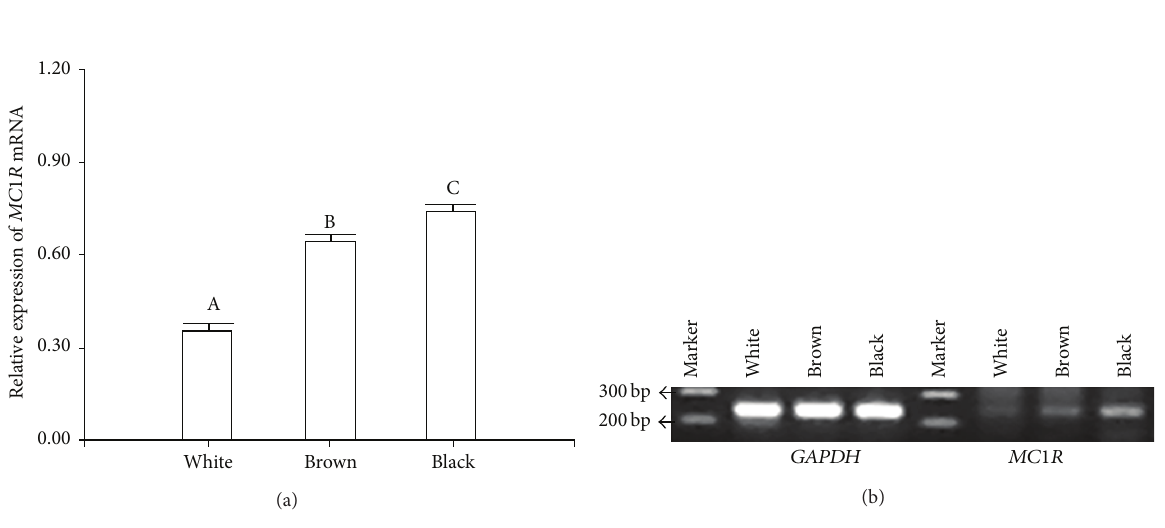
Figure 4: Gene expression of MC1R mRNA in white, brown, and black alpaca. (a) Relative expression of MC1R transcripts was measured using RT-PCR methodology and normalized against the reference gene GAPDH . Data are shown as the mean ± SE ( 𝑛 = 5 ) ( 𝑃 < 0.05 ). The distinct capital letters above the bars indicate a statistical significance among white and color morphs. (b) An ethidium bromide stained gel of MC1R and GAPDH